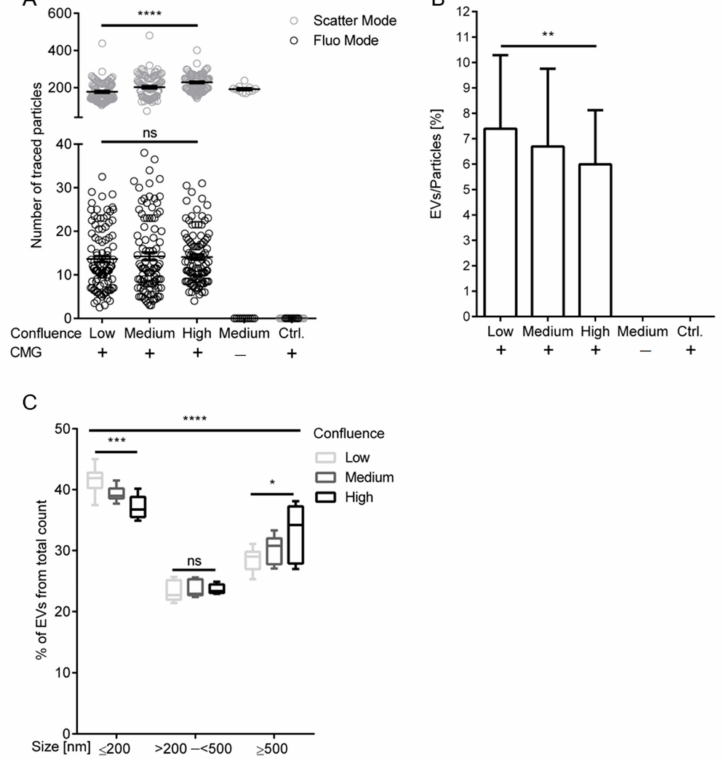
Figure 4. Increasing cell confluence influences release and size of endothelial derived extracellular vesicles. ( A ) Significant di ff erences in traced particles in the scatter mode with 184.9 for “Low”, 228.8 for “Medium” and 236.8 for “High” were detected. No significant di ff erence between particle traces detected in fluorescence mode were found between the mean values of traced particles, 13.6 for “Low”, 14.3 for “Intermediate” and 14.1 for “High”. ( B ) Normalization of fluorescent extracellular vesicles (EVs) against their respective particle numbers detected in the scatter mode revealed increased EV:particle ratios of lower cell density groups with mean values of 7.4% in “Low”, 6.7% in “Medium” and 6.0% in “High”. ( C ) Size distributions of EVs, analyzed via fluorescence-triggered flow cytometry (FT-FC), shows significant shifts from small EV release to increased large vesicle numbers in the di ff erent confluence groups. The confluence group “Low” shows an EV size distribution with 41.53% in “Small” ( ≤ 200 nm), 23% in “Intermediate” ( > 200– < 500 nm) and 29% in “Large” ( ≥ 500 nm). For “Medium” and “High” 39% and 37% in “Small”, 24% and 24% in “Intermediate”, and 30% and 33% in “Large” were detected, respectively. n = 3 cell donors, **** = p < 0.0001, *** = p < 0.001, ** = p < 0.01, * = p < 0.05, ns = p > 0.05. Error bars indicate the mean values ± the standard deviation in bar graphs and ± standard error of mean in scatter